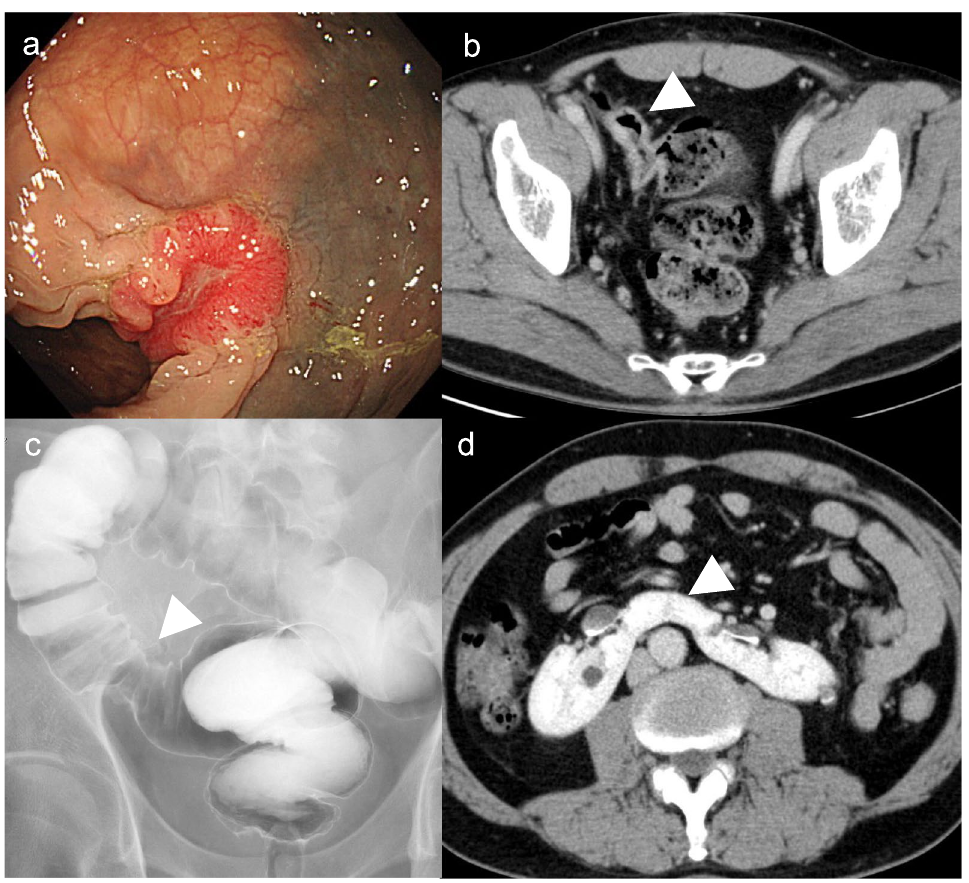
Fig. 1 Preoperative findings. a Colonoscopy revealed a type-2 tumor in the sigmoid colon. b A contrast-enhanced computed tomography revealed sigmoid colon cancer (white arrowhead). c A contrast-enema revealed sigmoid colon cancer (white arrowhead). d The isthmus of the horseshoe kidney (white